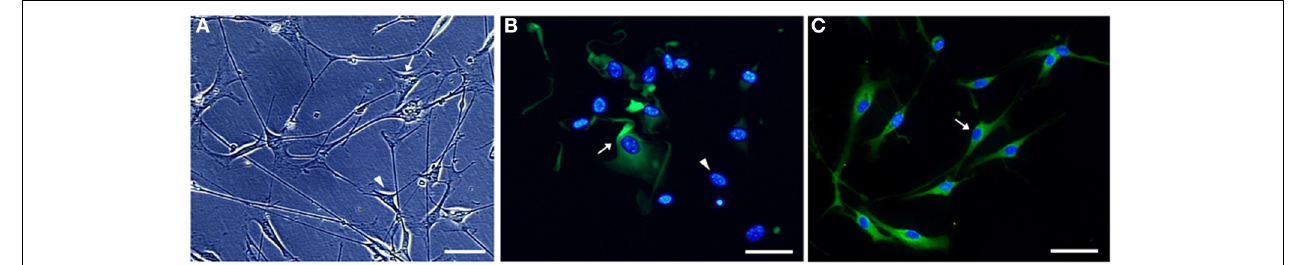
FIGURE 3 | Microphotographs of Schwann cell cultures obtained from sciatic nerve of a 60 days old SOD1 G93A mouse. Non-purified (A,B) and Thy1.2 antibody/rabbit serum complement-eliminated fibroblast [purified, (C) ] Schwann cell cultures are shown under phase-contrast (A) and immunofluorescence (B,C) microscopy. Cultured Schwann cells were evidenced by means of S100 immunofluorescence (greenish color), and the cell nuclei (bluish color) were stained by DAPI (B,C) . The different